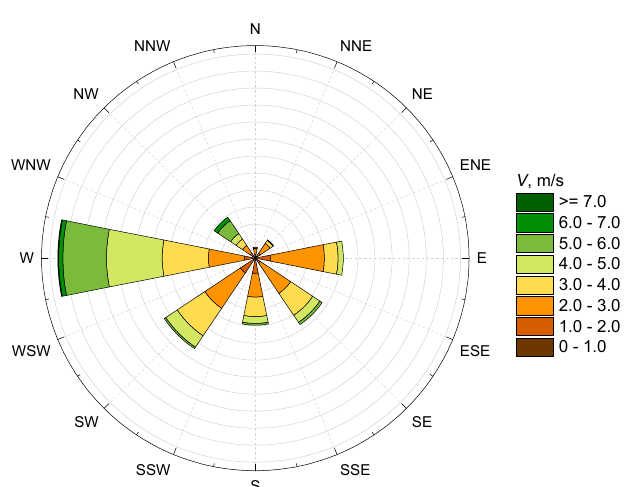
Figure 7. Air temperature for Bialystok station.